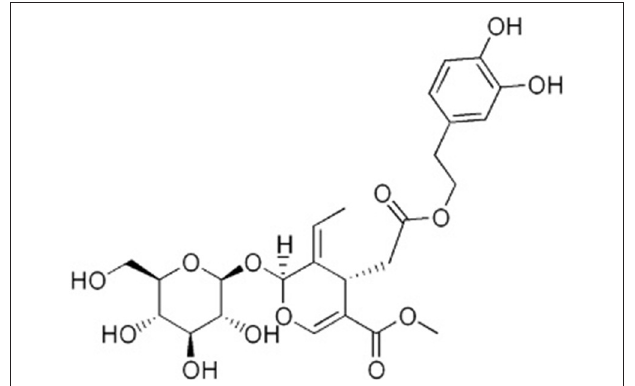
FIGURE 2 | Molecular structure of